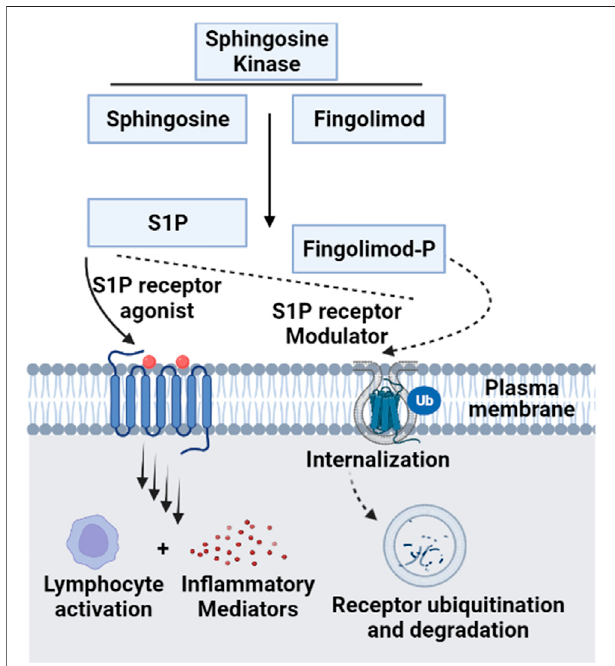
FIGURE 7 | Molecular mechanism of Fingolimod as a functional antagonist for S1P receptors. Since Fingolimod structurally resembles S1P, the former can compete with Sphingosine for Sphingosine kinase and get activated by phosphorylation into Fingolimod phosphate. This active form modulates S1P receptors via internalization and ubiquitination, acting as a functional antagonist for S1P ligand on its receptors. This contributes to the regulatory functions of Fingolimod as an inhibitory of in fl ammatory cytokines production, which is upregulated by the disruption of S1P signaling (Van Doorn et al., 2010) [S1P, sphingosine 1 phosphate; Ub, ubiquitination]. This fi gure was generated using Biorender.com.